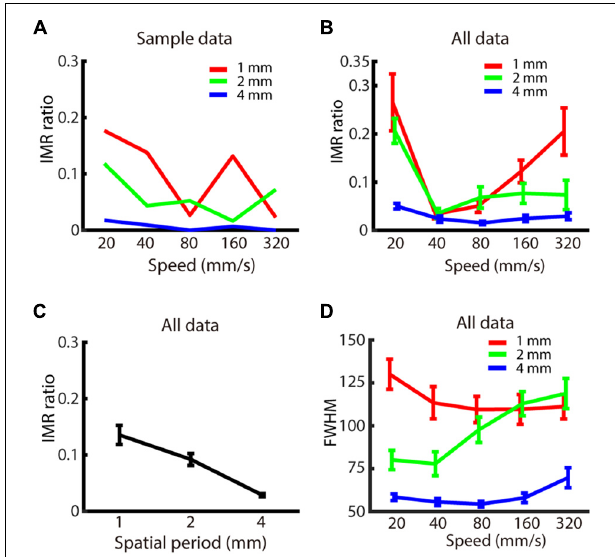
FIGURE 3 | Experiment 1: Spatio-temporal dependence of IMR. (A) IMR ratios across spatio-temporal parameters for one participant. (B) IMR ratio averaged across participants as a function of spatial period and speed (red: 1 mm, green: 2 mm, blue: 4 mm). (C) IMR ratio as a function of grating spatial period. (D) FWHM of A 1 averaged across participants as a function of spatial period and speed (red: 1 mm, green: 2 mm, blue: 4 mm). Bars indicate standard error of the mean.